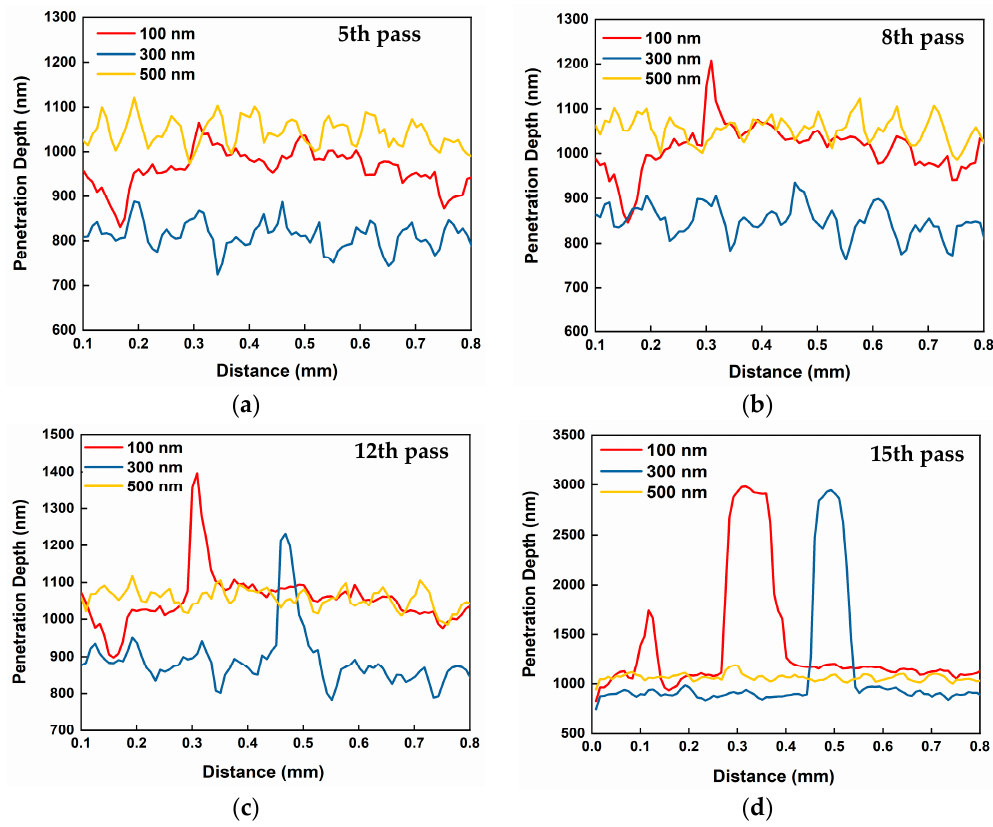
Figure 9. ( a – d ) Evolution of penetration depth at di ff erent passes during repetitive wear test at 1.5 N.